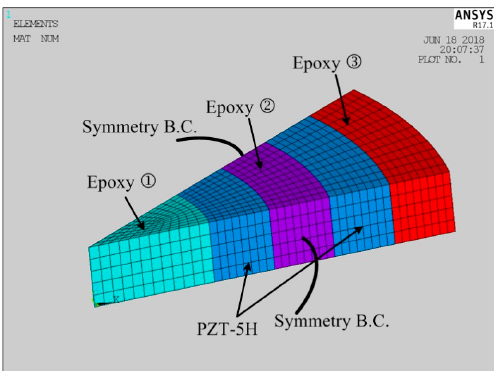
Figure 2. Three-dimensional finite element model of one-twelfth of the transducer.